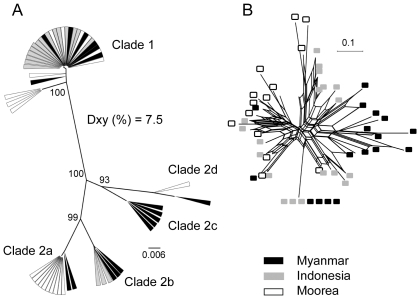
Phylogenetic relationships inferred from maximum likelihood analysis of CO1 and phylogenetic network of nuclear loci.(A) Unrooted ML network of CO1. Numbers on the branches represent ML bootstrap values. Geographic locality is represented by rectangle color as in figure 1B. (B) Phylogenetic networks of the concatenated nuclear loci using uncorrected ‘p’ genetic distances, colored by geographic locality.